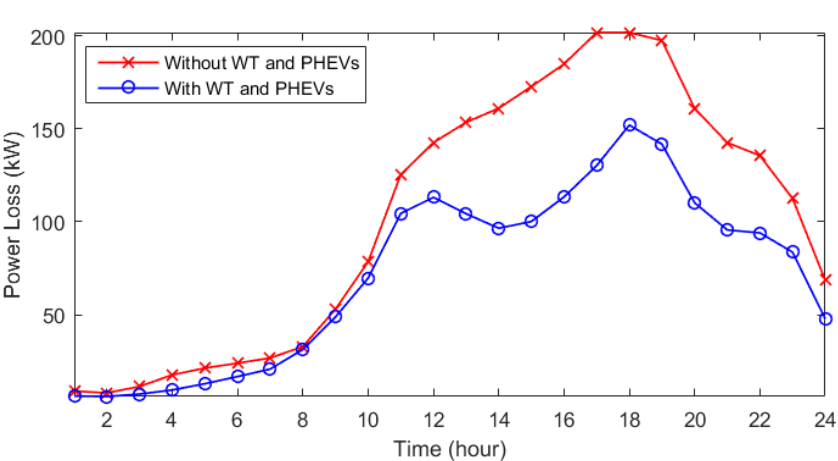
Figure 7. Power loss of the 33-bus distribution network with and without WT and PHEVs using the IGJO.